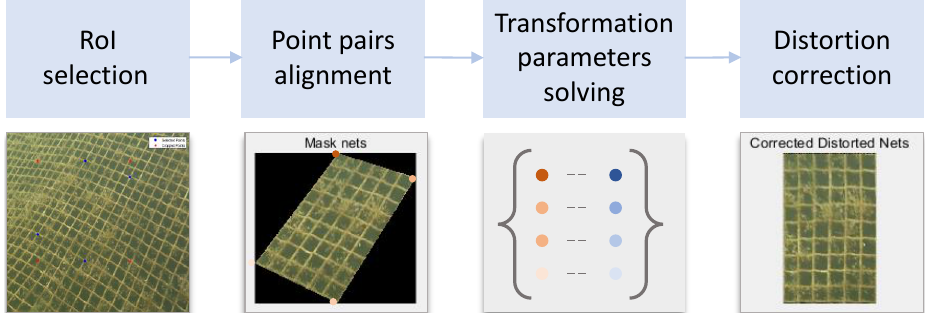
Figure 3. Flowchart of distortion